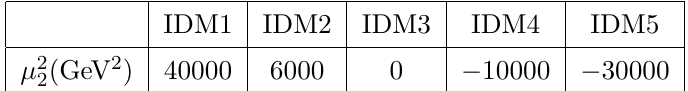
labelled as IDM1-5 are 2